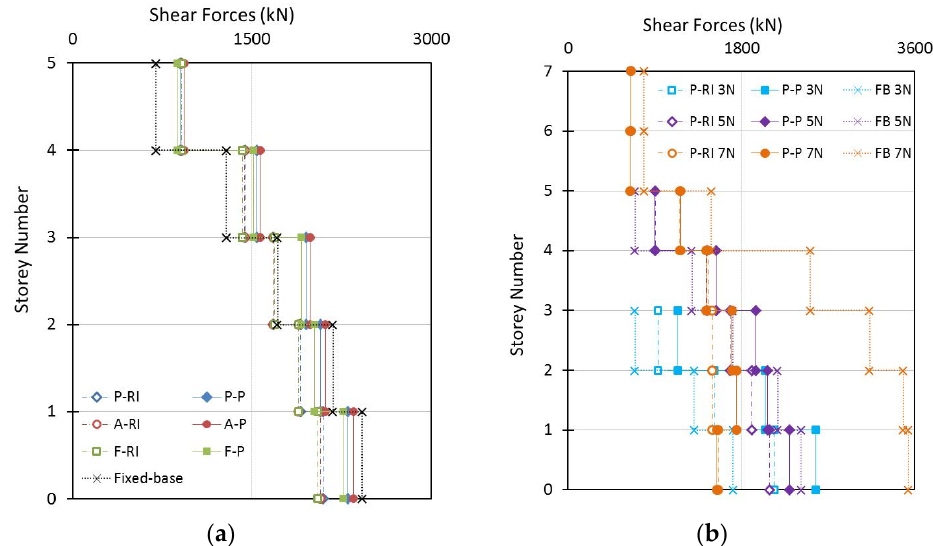
Figure 10. Maximum shear force distribution of the analyzed systems with different support condi- tions. ( a ) 5-storey Building; ( b ) 3-, 5- and 7-storey Buildings. As expected, the shear force values in the fixed-base case with the 7-storey building (FB 7N) are greater than the ones of the fixed-base cases with the 3- and 5-storey buildings.